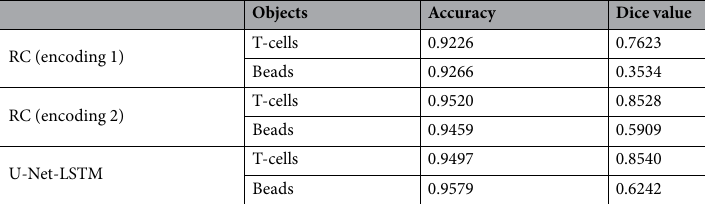
Table 4. Performance evaluation of reservoir computing models and the U-Net-based LSTM for Jurkat T-cell and bead segmentation and differentiation in single-emission recordings ( task 3 ; test set: 1155 frames from five imaging sequences). Corresponding class-wise normalized confusion matrices are presented in Fig.